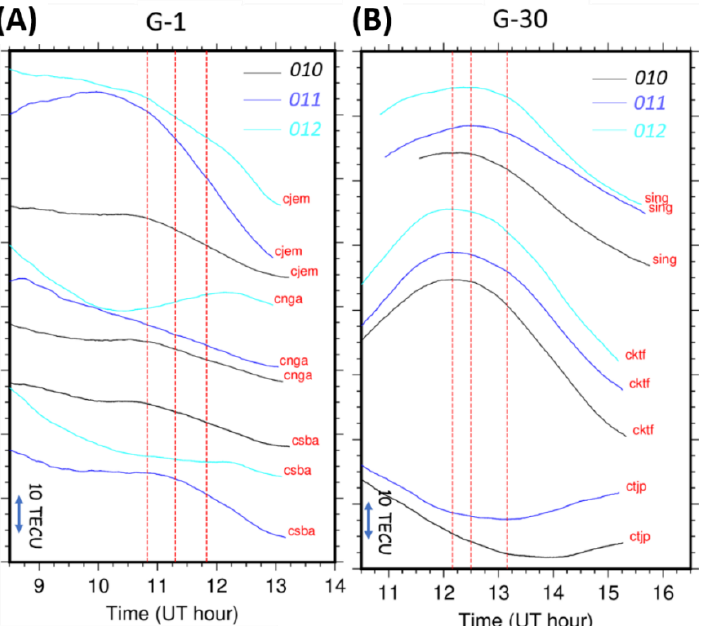
Figure A4. GNSS-TEC time series on reference days shown in black (10 January), blue (11 January) and cyan (12 January) curves from stations in and around the Java (G1, A ) and Sumatra (G30, B ) regions. The vertical red dashed lines indicate the epochs shown in Figures 2 and 3. We did not see any anomalous TEC behaviours on these reference days.